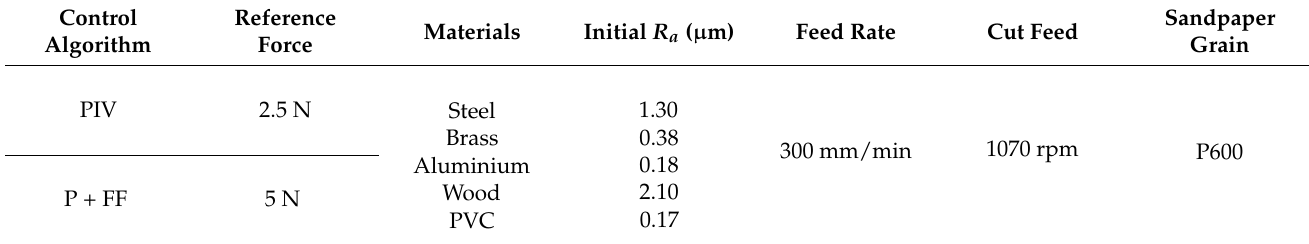
Table 1. Design of the